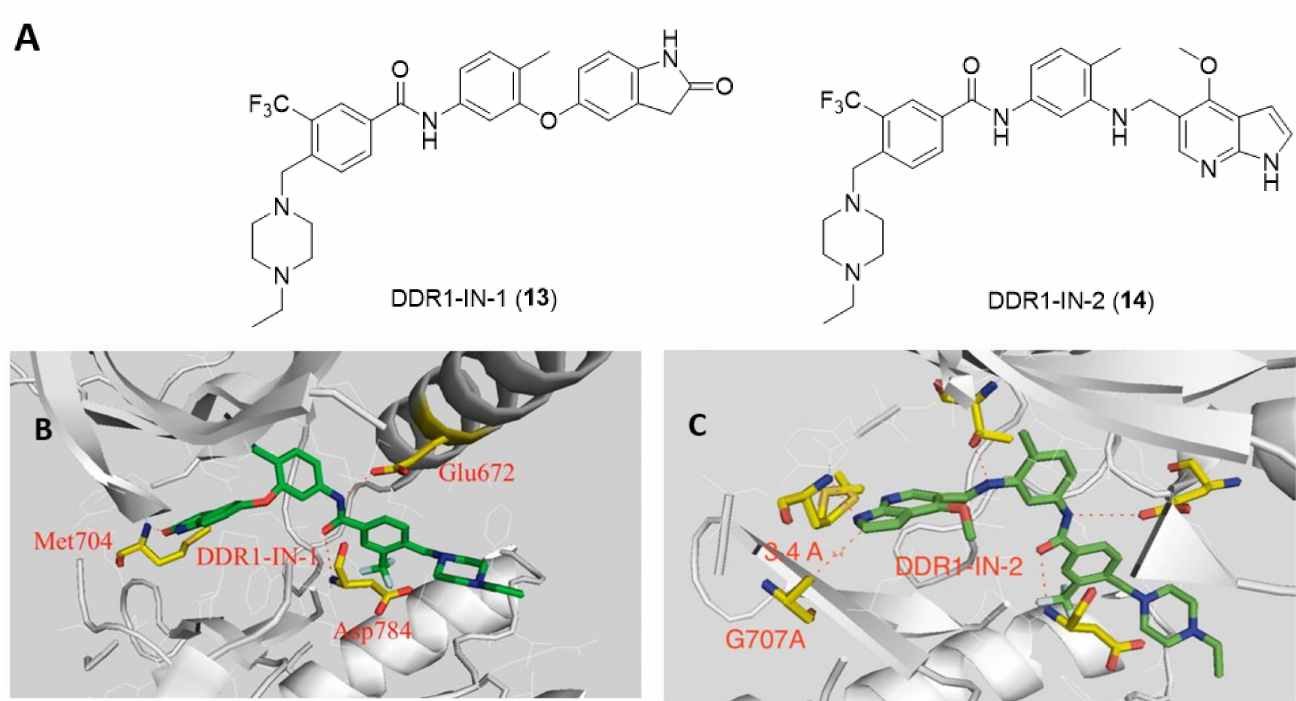
Figure 4. ( A ) Chemical structures of compounds 13 and 14 ; ( B ) X-ray co-crystal structure of compound 13 with DDR1 kinase. Reprinted with permission from Ref. [133]; ( C ) Compound 14 docking model into the DDR1 G707A mutation. Reprinted with permission from Ref.